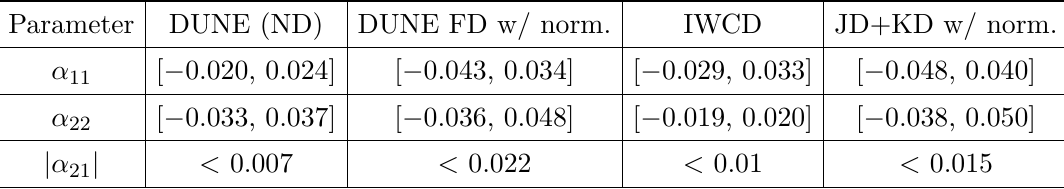
Table 9 . 90% C.L. (1 d.o.f.) bounds on the NUNM parameters α 11 , α 22 , and | α 21 | obtained with and without near detectors in DUNE and JD+KD. Note that IWCD is the near detector for JD+KD